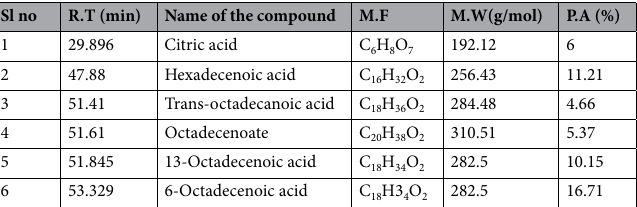
Table 3. Phytochemical components of Terminalia Chebula (kadukkai) ethyl acetate fraction by GC–MS.